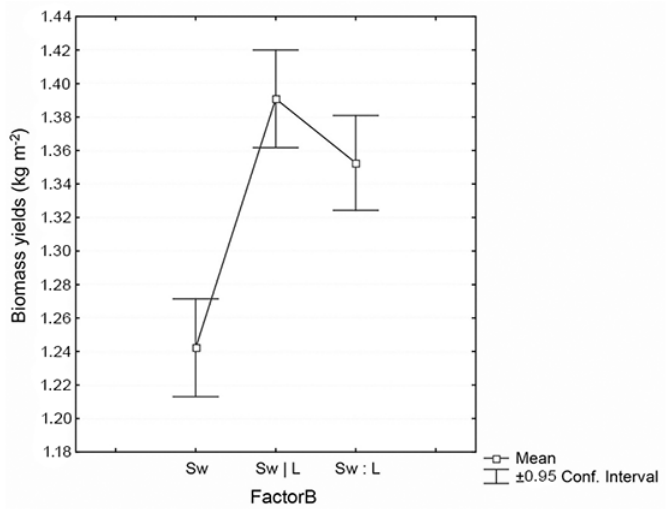
Fig. 6 Biomass yields of switchgrass in different growing conditions (Factor B), 2012–2016.